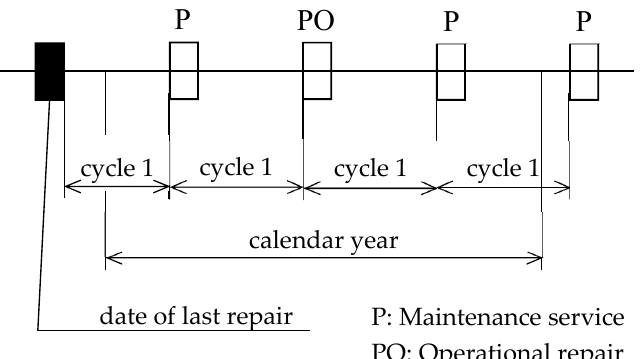
Figure 11. Annual maintenance plan for group of importance II and III